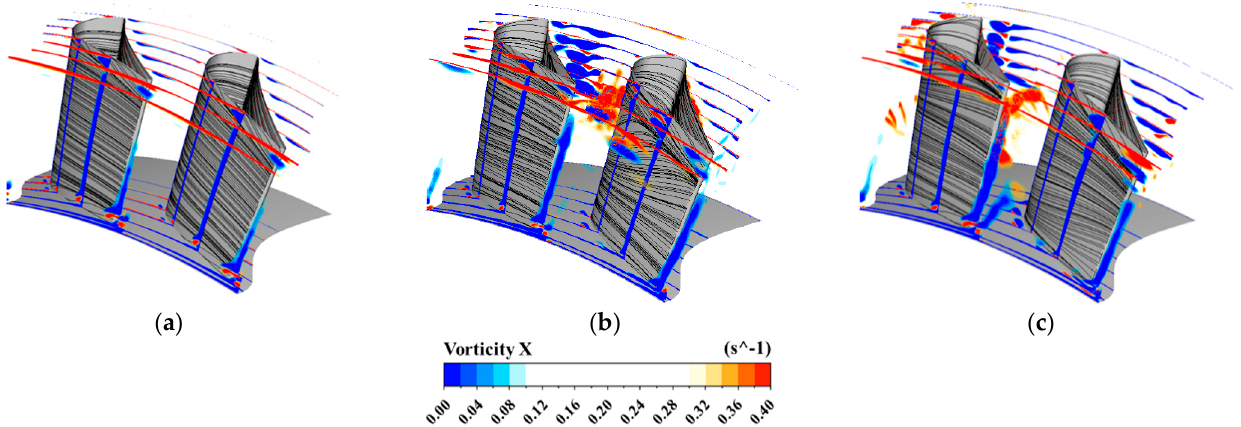
Figure 22. Comparison of vortex structure due to the swirl clocking − SL12 SP10 model: ( a ) SL12 SP10 No swirl; ( b ) SL12 SP10 SW@LE; ( c ) SL12 SP10 SW@PC.